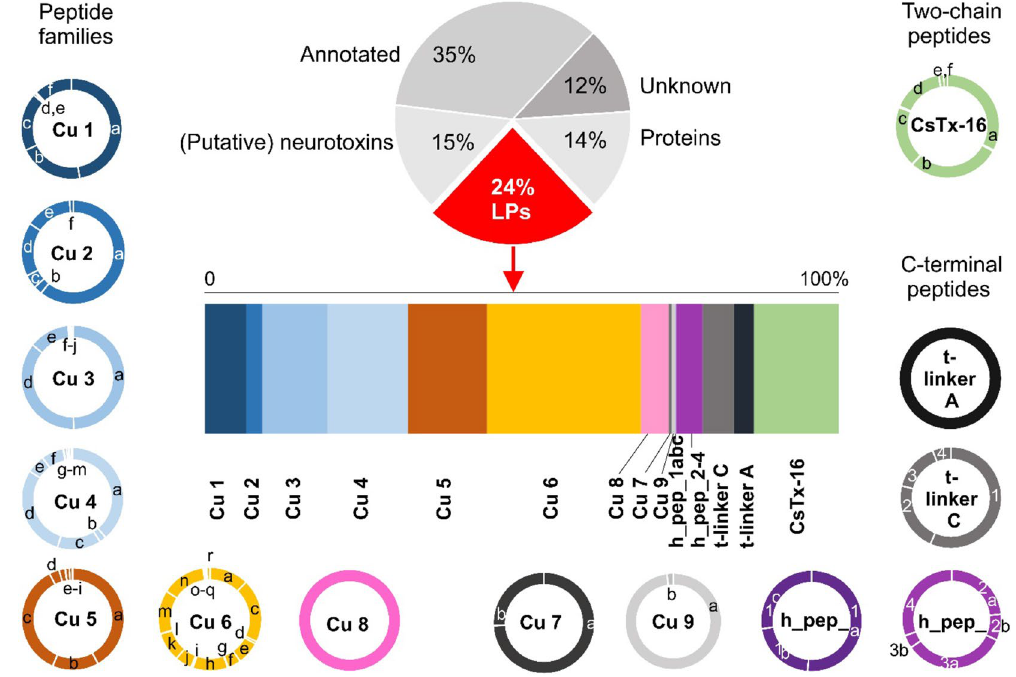
Figure 1. Transcriptome analysis of the venom glands of C. salei . The upper pie chart shows the distribution of all identified contigs referring to peptides and proteins 20 . Below this, the percentage distribution (reads) of all identified LPs is presented. The distribution and quantity of related peptides within the different peptide families are also illustrated in pie charts, in identical colors, corresponding to their percentage presence in the transcriptome. CsTx-16 is counted as two-chain